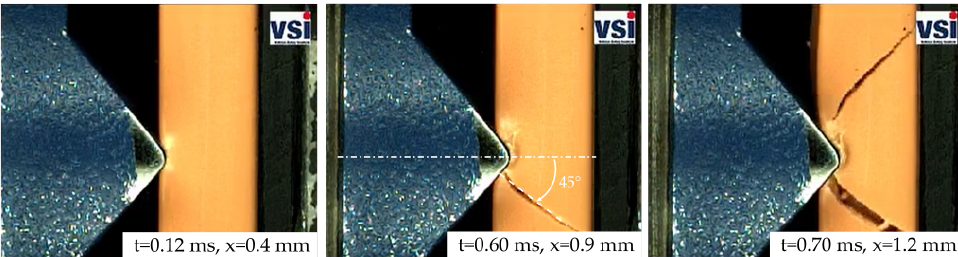
Figure 10. Exemplary high-speed sequences from a dynamic SHPB test on a PA6GF30 busbar in combination with impactor